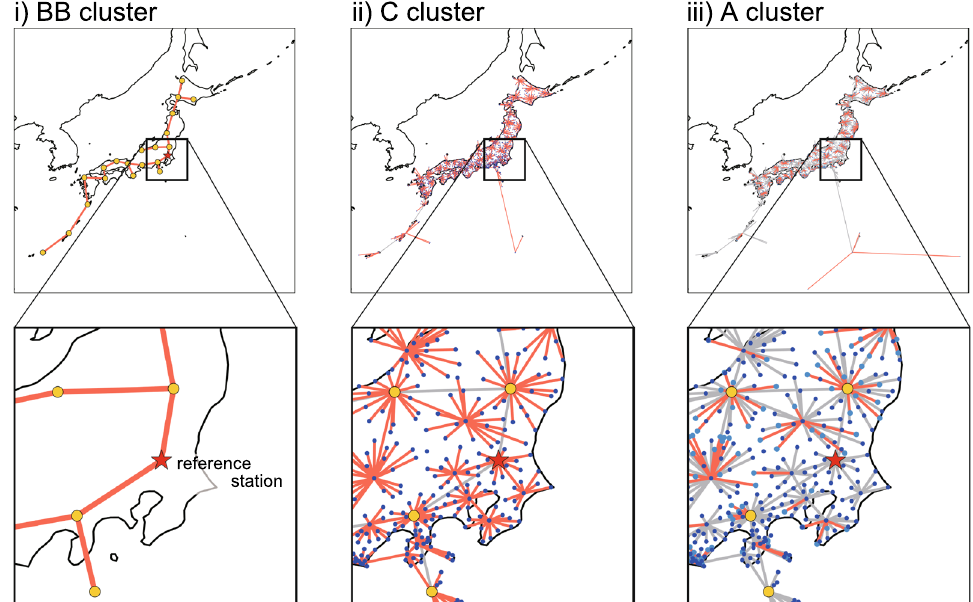
Fig. 3 Network combination procedure. The yellow, dark blue, and light blue circles denote the GEONET stations. The star denotes the reference station. The red lines indicate the baselines spanning each cluster, while the gray lines are those defined in the previous